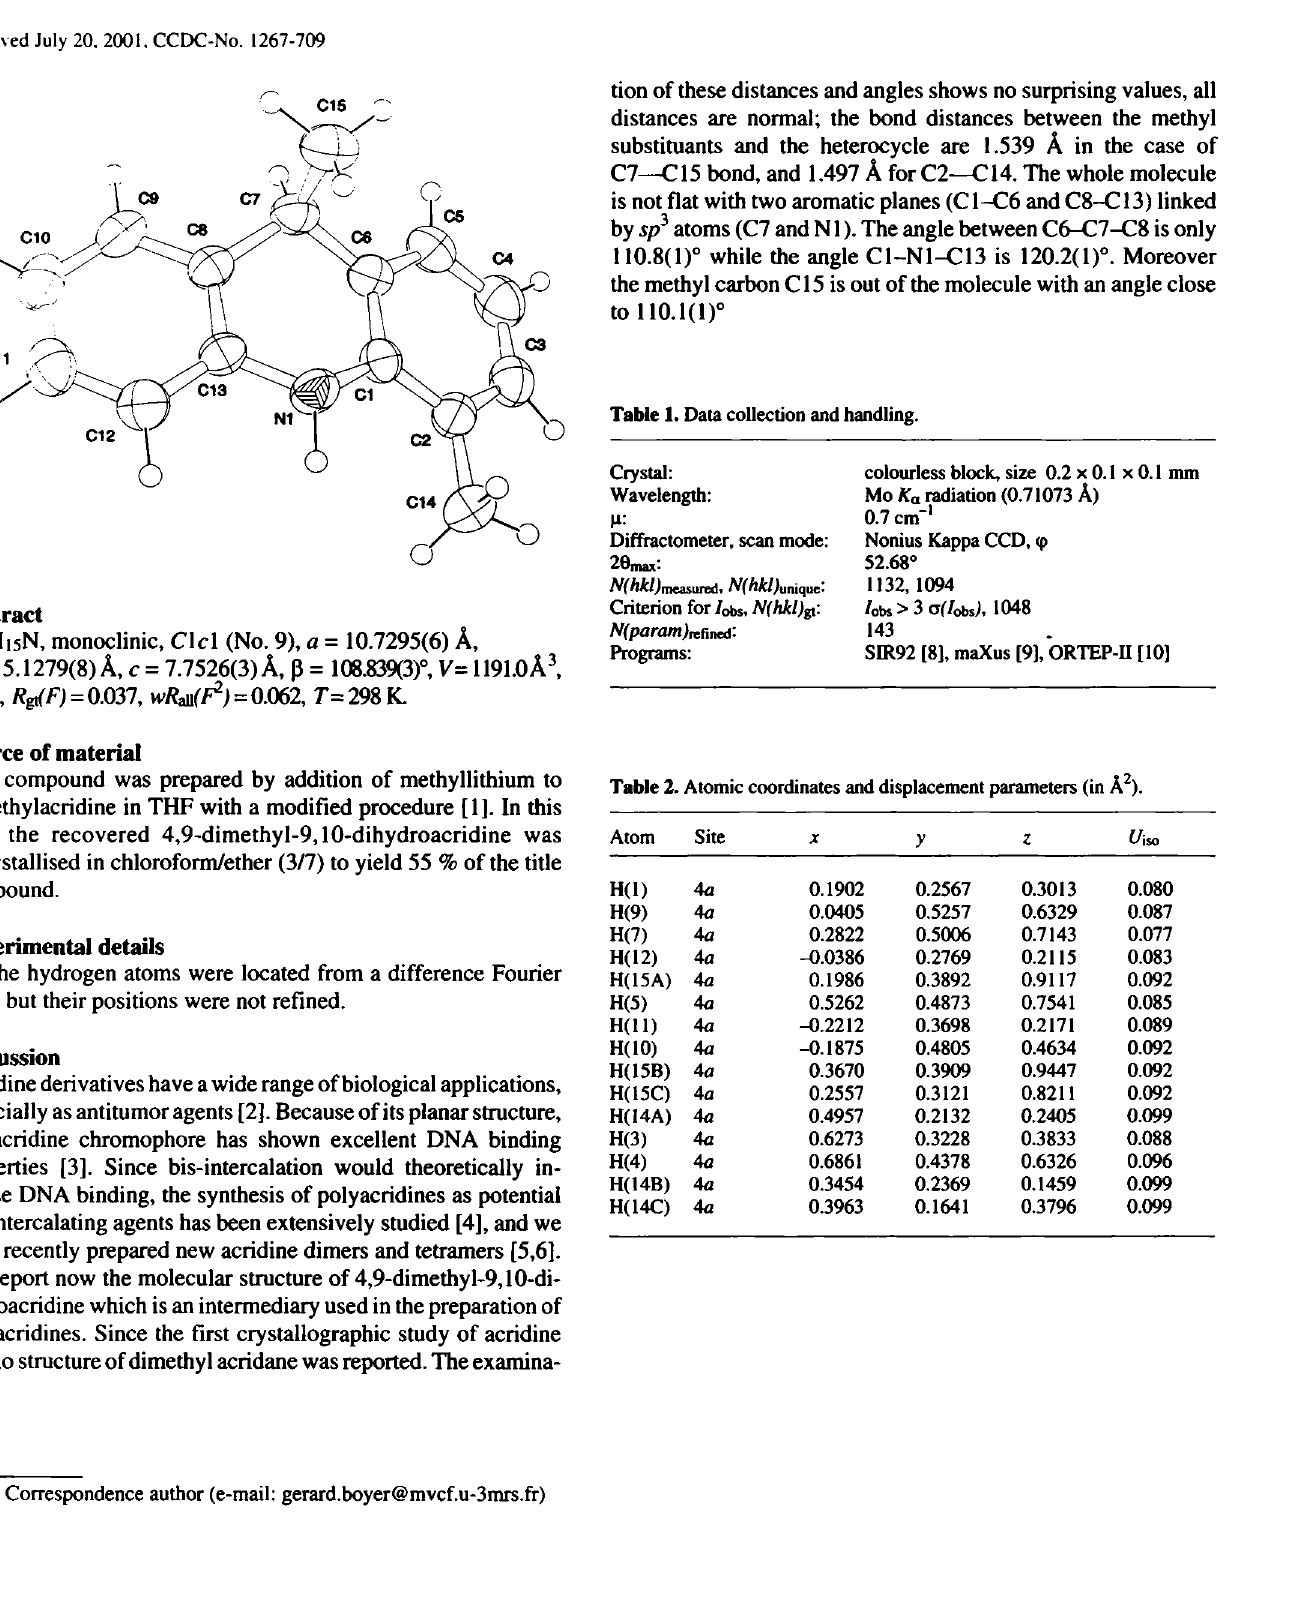
Table 1. Data collection and handling.